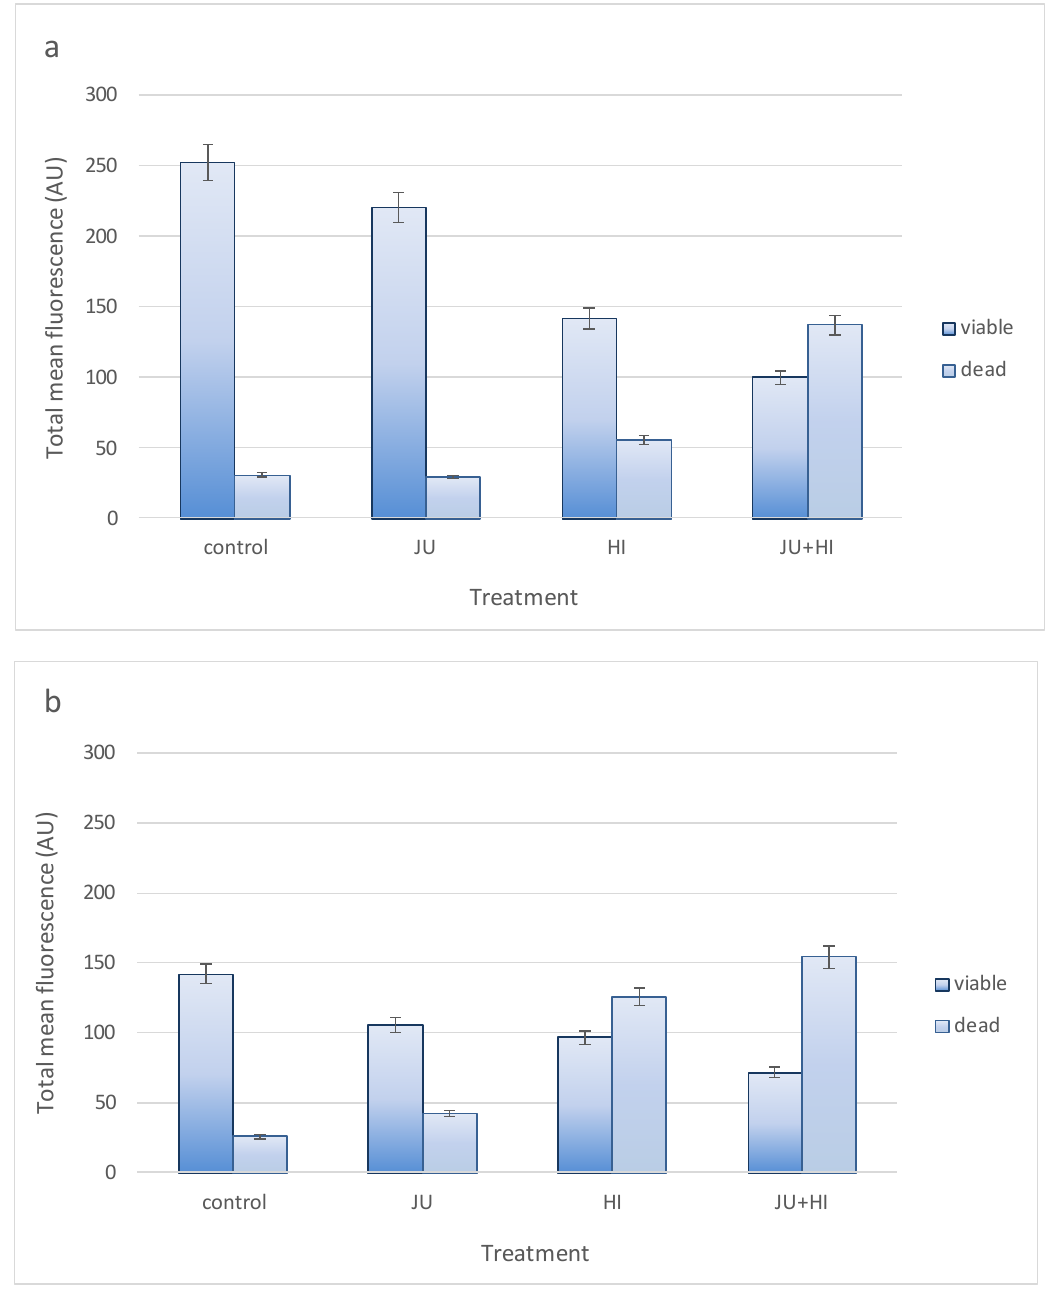
Figure 6. Total mean fluorescence measured for propidium iodide and SYTO ® 9 stained biofilms of M. avium ( a ) and M. intracellulare ( b ) on stainless steel discs, as visualized with confocal laser scanning microscopy (control, three-day-old biofilm of M. avium treated for 22 hours with 0.8 mg mL −1 J. communis EO (JU) and/or 0.012 mg mL −1 H. italicum EO (HI), and three-day-old biofilm of M. intracellulare treated for 22 hours with 0.8 mg mL −1 J. communis EO (JU) and/or 1.6 mg mL −1 H. italicum EO (HI). The experiment was repeated twice and a minimum of three images were analyzed and the mean fluorescence ± SD is shown.